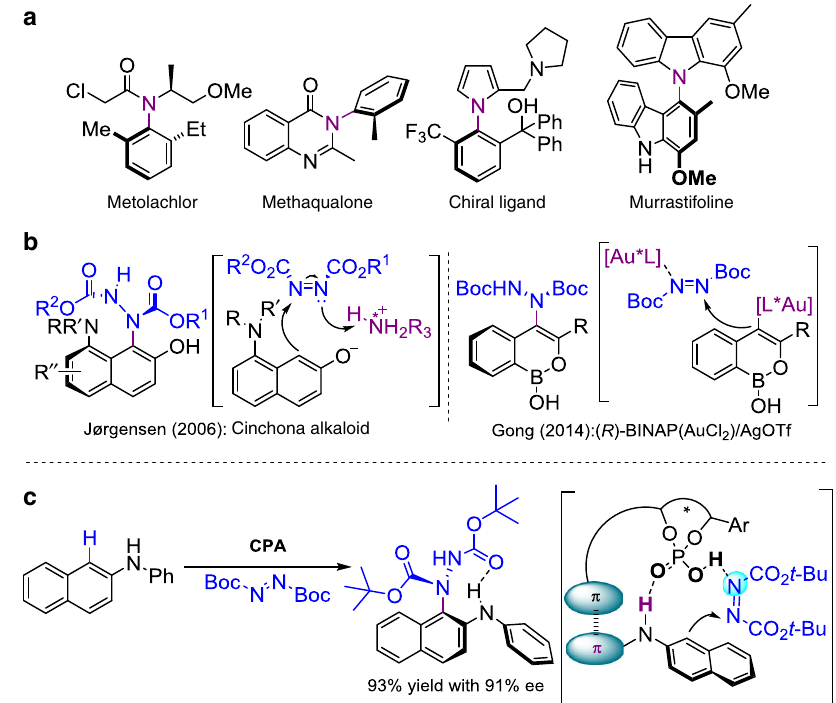
Fig. 1 N-C nonbiaryl axially chiral structure. a N-C axially chiral compounds. b Previous N-C atropisomers with azodicarboxylates. c This work: CPA- catalyzed direct atroposelective C-H aminations via a concerted control of π - π interaction and dual H-bond